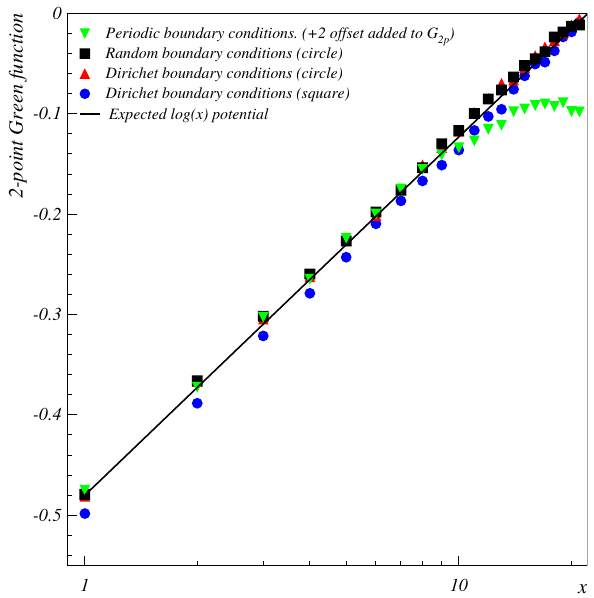
Fig. 13 Dependence of the force between two sources with the dis- tance L = 2 d separating them (system size). The fo u r different s y mbols are results for different values of the coupling g . (Details of these calcu- lations are discussed in Sect. E.1.3.) Points are fit with a linear function, yielding an overall χ 2 / ndf of 1.4. The uncertainties are taken as the difference between the force extracted near source 1 and the force near source 2